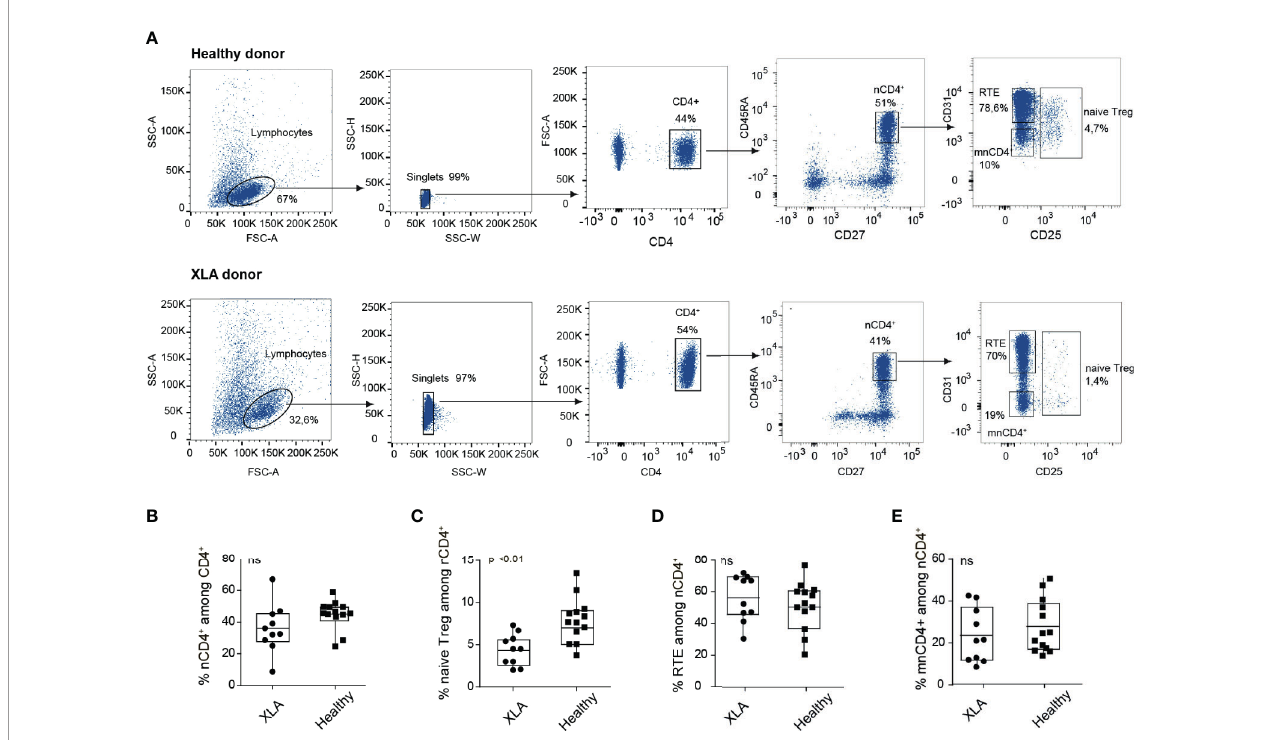
FIGURE 1 | Flow cytometry analysis of CD4 + subsets in healthy and XLA donors. (A) Gating strategy for cell sorting of nCD4 + subsets from healthy (top) and XLA (bottom) young donors, starting from discrimination of lymphocytes by forward (FSC) and side scatter (SSC) pro fi les and sequential separation of singlets (left), after which CD4 + cells were selected (middle). nCD4 + were selected as CD45RA + CD27 + , from which RTE, mnCD4 + and naïve T reg cell subsets were subsequently gated (right). (B) Percentage of nCD4 + cells among the CD4 + subset and of (C) naïve T reg , (D) RTE, and (E) mnCD4 + among the nCD4 + population in XLA (N = 10) and healthy (N = 13) donors. p -values were calculated with the Wilcoxon rank-sum test. NS, non signi fi